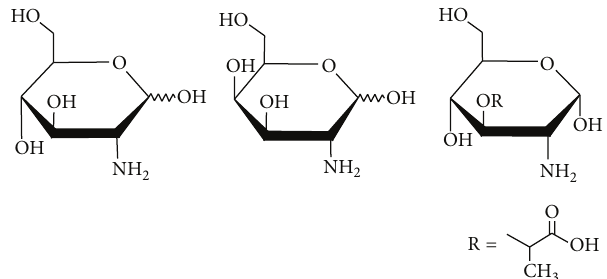
Figure 1: Chemical structures of (from left to right) glucosamine, galactosamine, and muramic